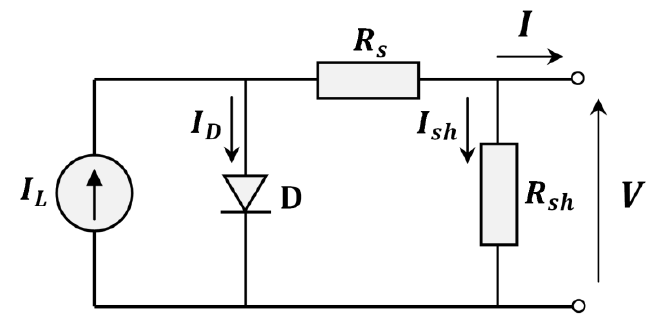
Figure 1. Electrical circuit of thesolar cell 5-parameter